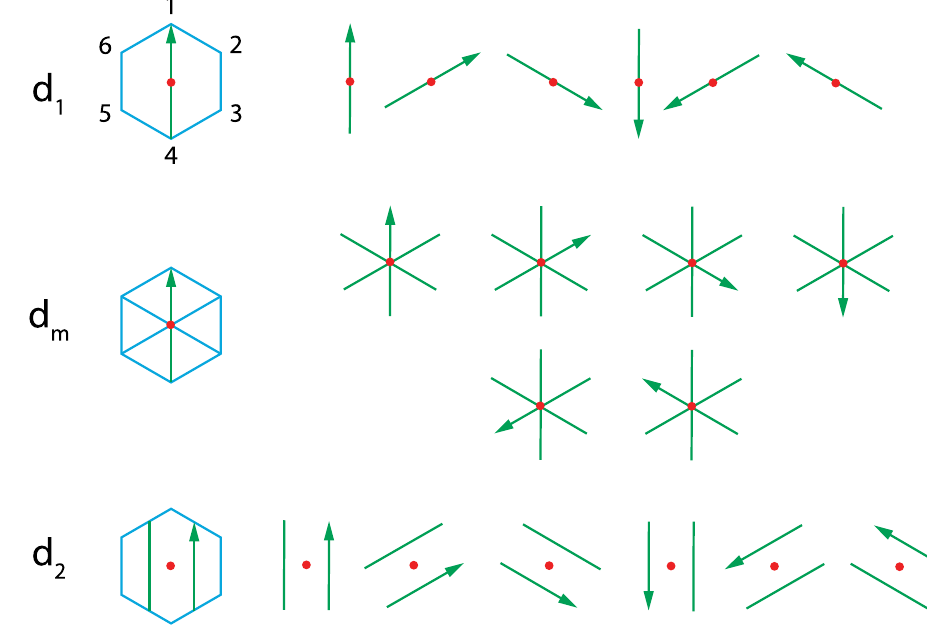
Figure 44. Inheritance from d 1 by all d -knives through identi fi cation and direction of